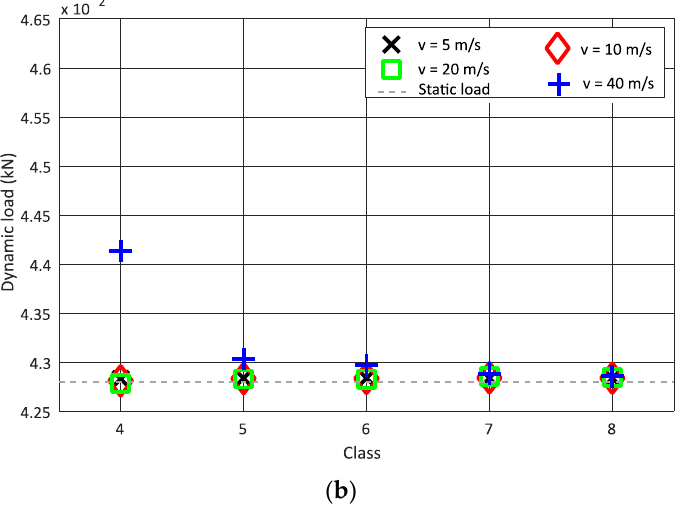
Figure 6. Influence of vehicle speed on the dynamic load: ( a ) Alfa Pendular; ( b ) freight train.